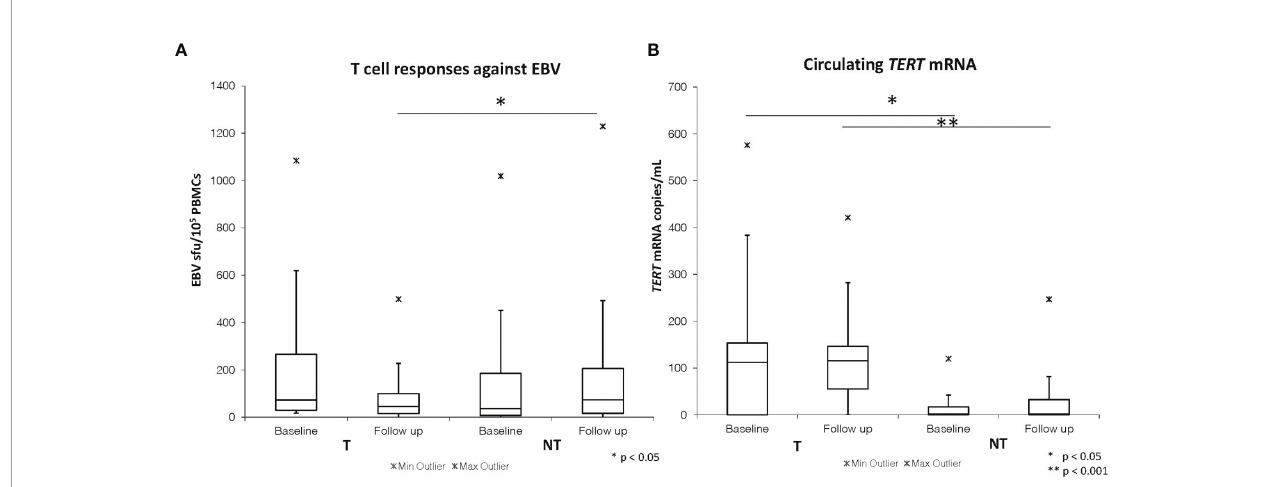
FIGURE 1 | Baseline and follow-up EBV ELISpot T cell responses (A) and plasma TERT mRNA levels (B) in SOT patients developing (T) and not developing tumors (NT).